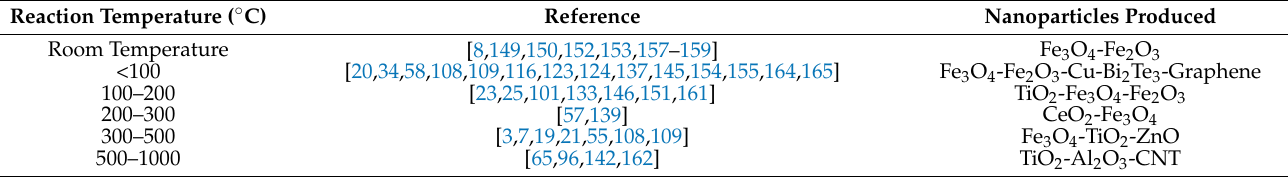
Table 6. Temperature during nanoparticle synthesis reaction in studied research. Reaction Temperature ( ◦ C) Reference Nanoparticles